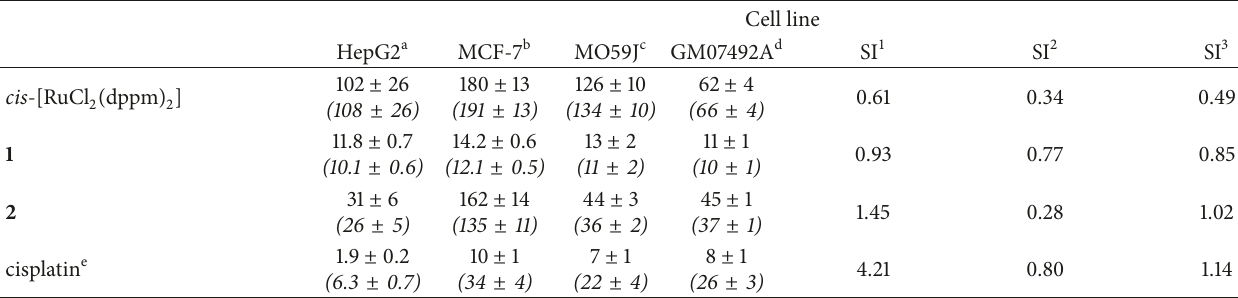
Table 2: Inhibitory activity of ruthenium complexes and cisplatin against normal and tumor cell lines for 24h incubation, expressed as IC 50 , 𝜇 g ⋅ mL −1 ( 𝜇 M ) and selectivity index